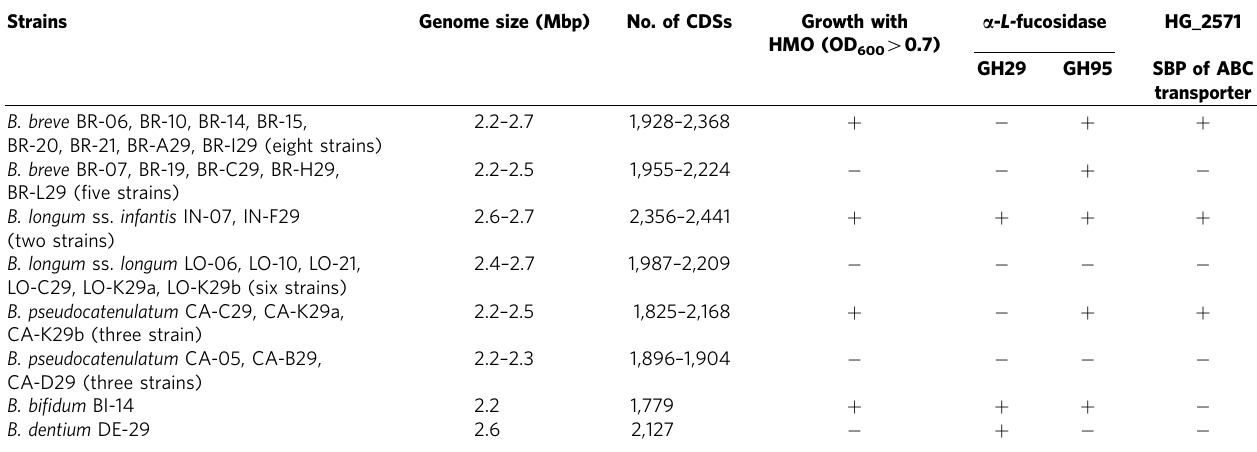
Table 1 | Summary of the draft genomes of the 29 bifidobacterial strains.